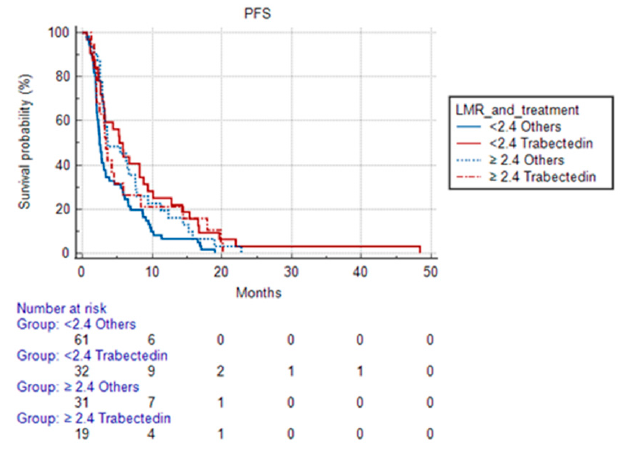
Figure 4. Progression-free survival according to LMR and treatment (Trabectedin vs. others).